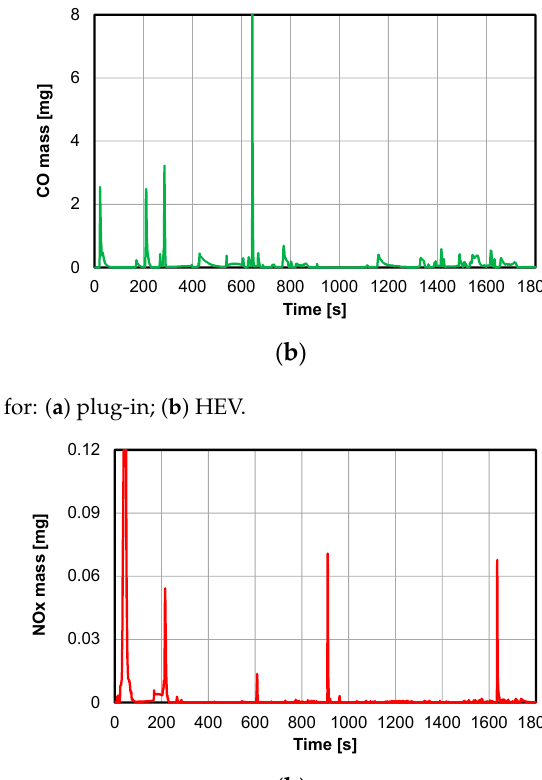
Figure 17. The CO 2 mass versus time for: ( a ) plug-in; ( b ) HEV.